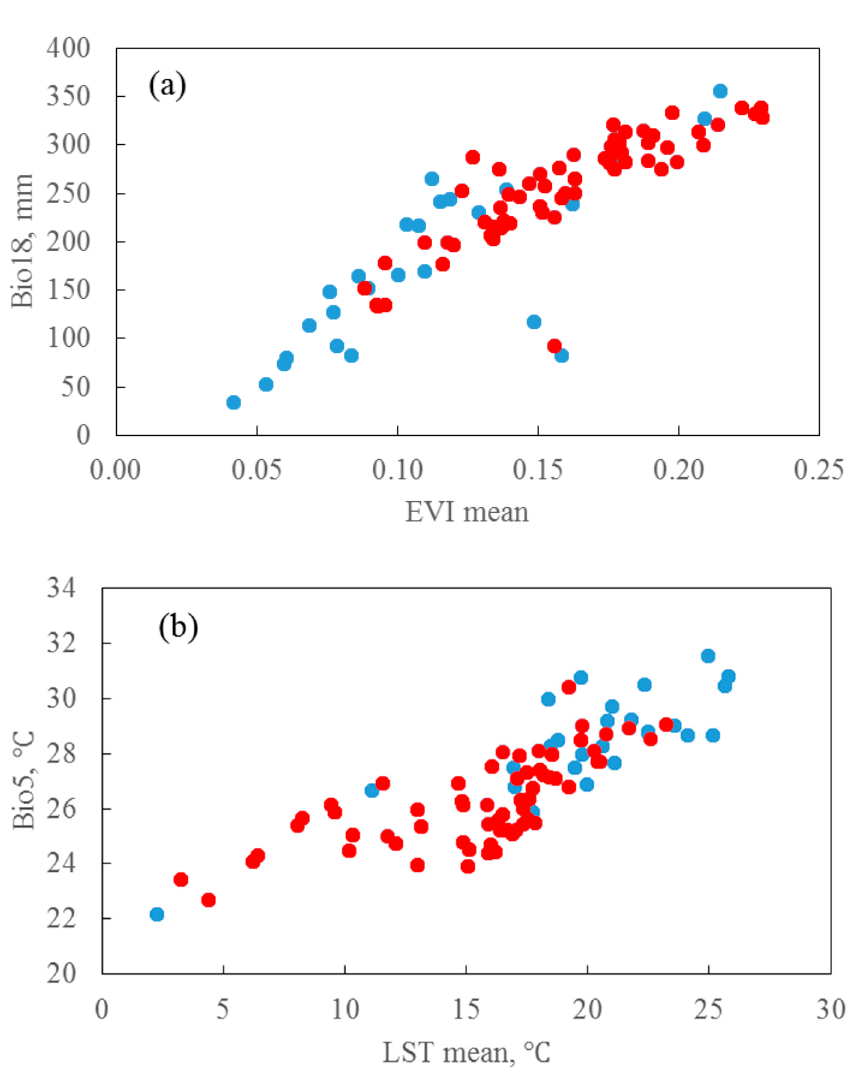
Figure 9. Modeled ecological niche of human brucellosis (HB), according to: ( a ) the precipitation of warmest quarter (Bio 18) and mean enhanced vegetation index (EVImean); and ( b ) max temperature of warmest month (Bio 5) and mean land surface temperature (LSTmean). All dots represent the ecological niche of HB with the suitable ecological niche highlighted in red, which explains over 50% of HB in historical records.